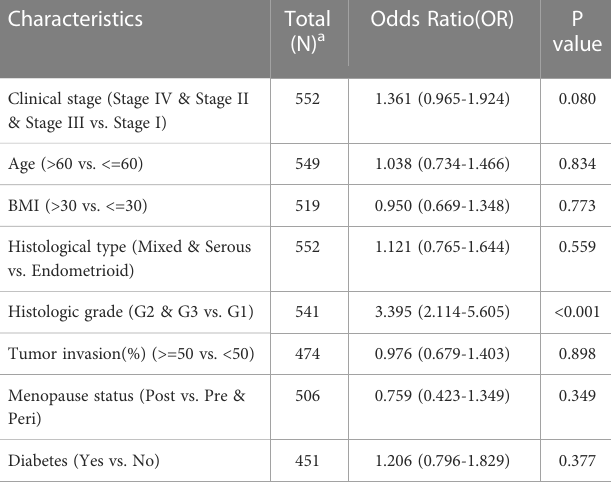
TABLE 1 The results of the logistic regression model obtained from the RNA-seq data in the TCGA database.